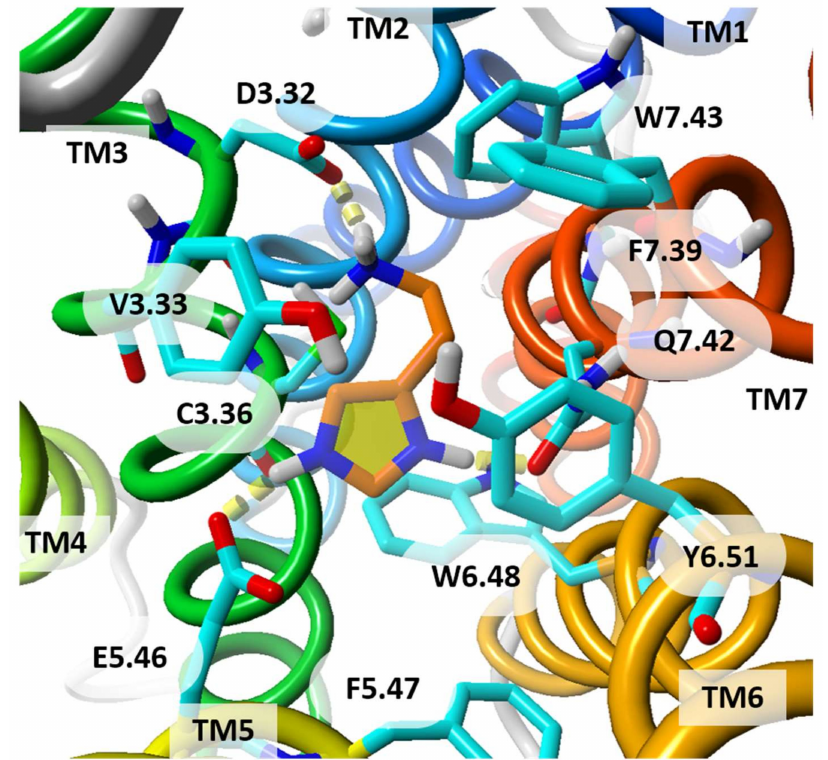
Figure 7. Histamine molecule docked to the homology model of hH 4 R. The histamine is doubly positively charged. The amine moiety of histamine is bound to D 3.32 whereas the imidazole ring is bound to E 5.46 and Q 7.42 . The histamine hydrophobic linker is exposed toward hydrophobic residues F 7.39 and inversely rotated W 7.43 . The residue numbers are shown in Ballesteros-Weinstein numbering scheme. Histamine is shown with its carbon atoms colored in orange. View from extracellular side. TM helices are colored from blue (TM1) to red